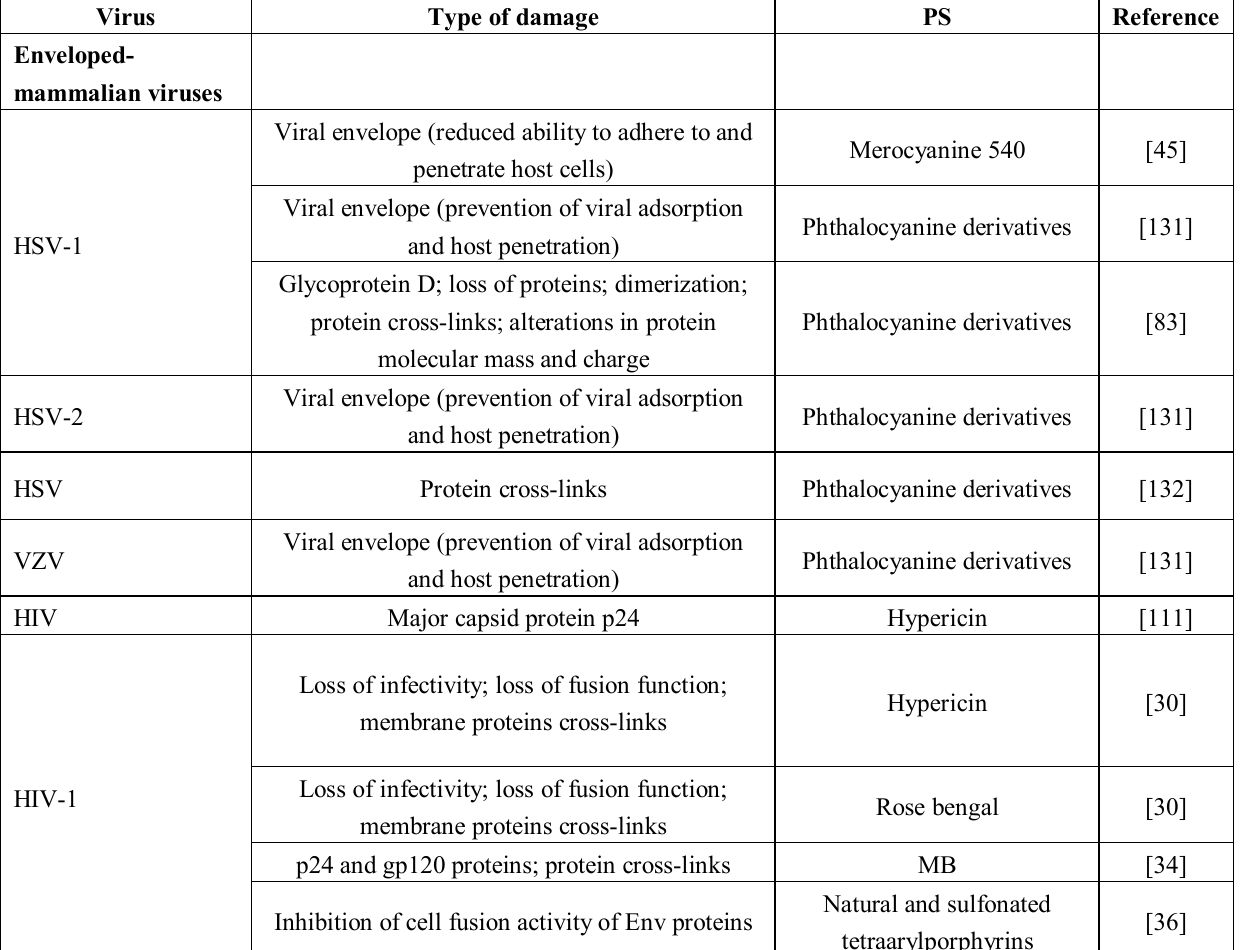
Table 4. Degradation of viral outer structures after mammalian viruses and bacteriophages